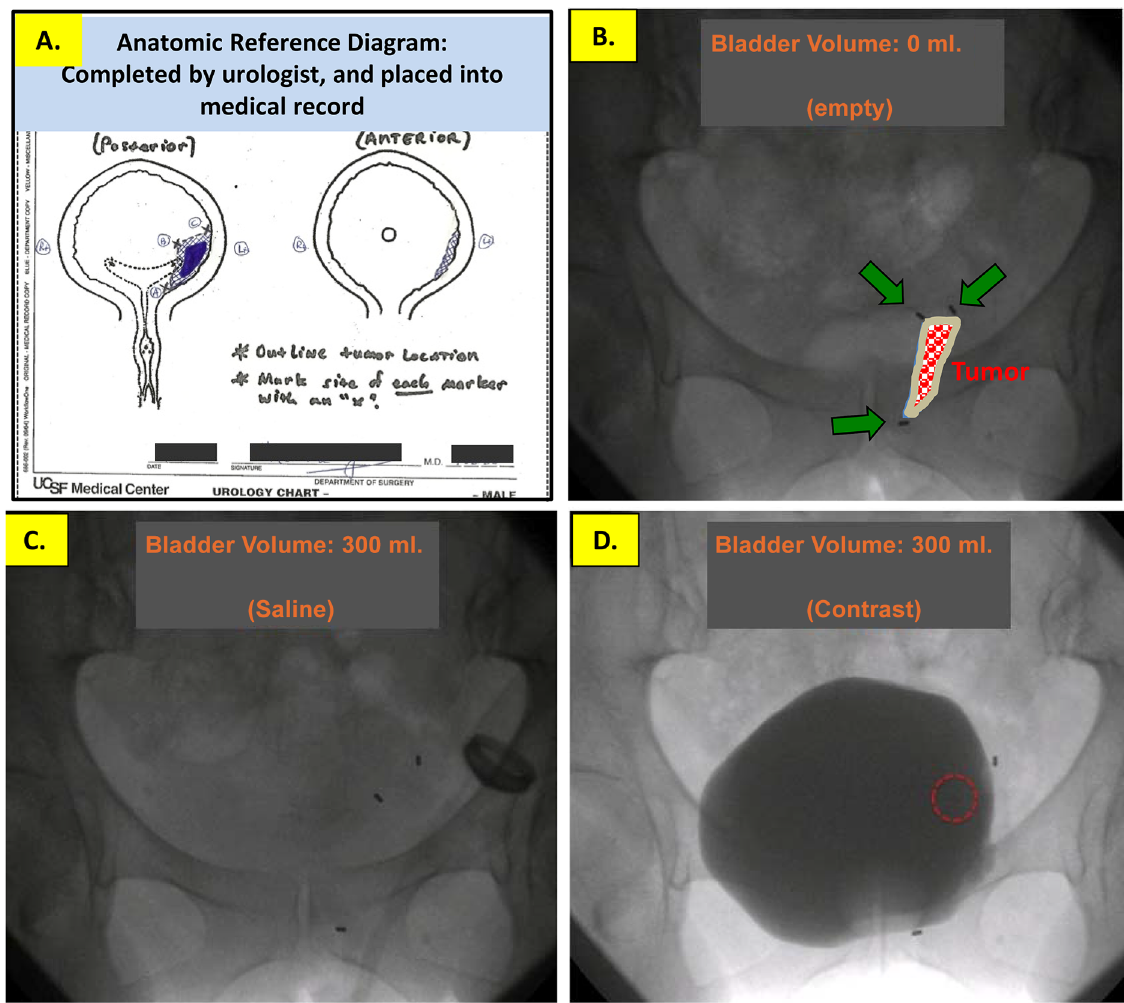
Figure 5. Intraoperatively, we completed a bladdermap pictogram of the anterior and posterior walls of the bladder. On this bladder map we drew the location of the bladder tumor, additional biopsy sites, and, abnormal anatomy (e.g. diverticulae, ectopic ureteral orifice, etc.), and, the location of each fiducial marker placed ( A. ). We numbered each marker on the bladder map, and also referred to the numbered markers in the dictated operative note. The bladder map was entered into each patient’s electronic medical record, for future reference by our Radiation Oncology colleagues during dosimetry planning. Intraoperative fluoroscopic images of the catheterized bladder following placement of three fiduciary markers at the site of a left anterior-lateral bladder wall tumor: ( B. ) Bladder empty. The location of the tumor and resection margin are outlined by three fiducial markers; center is filled in color. The bladder was then filled with 300 cc. of saline ( C. ), and separately with diluted contrast ( D. ), to assess marker movement with bladder filling and to compare the location of each marker during independent filling studies of equal